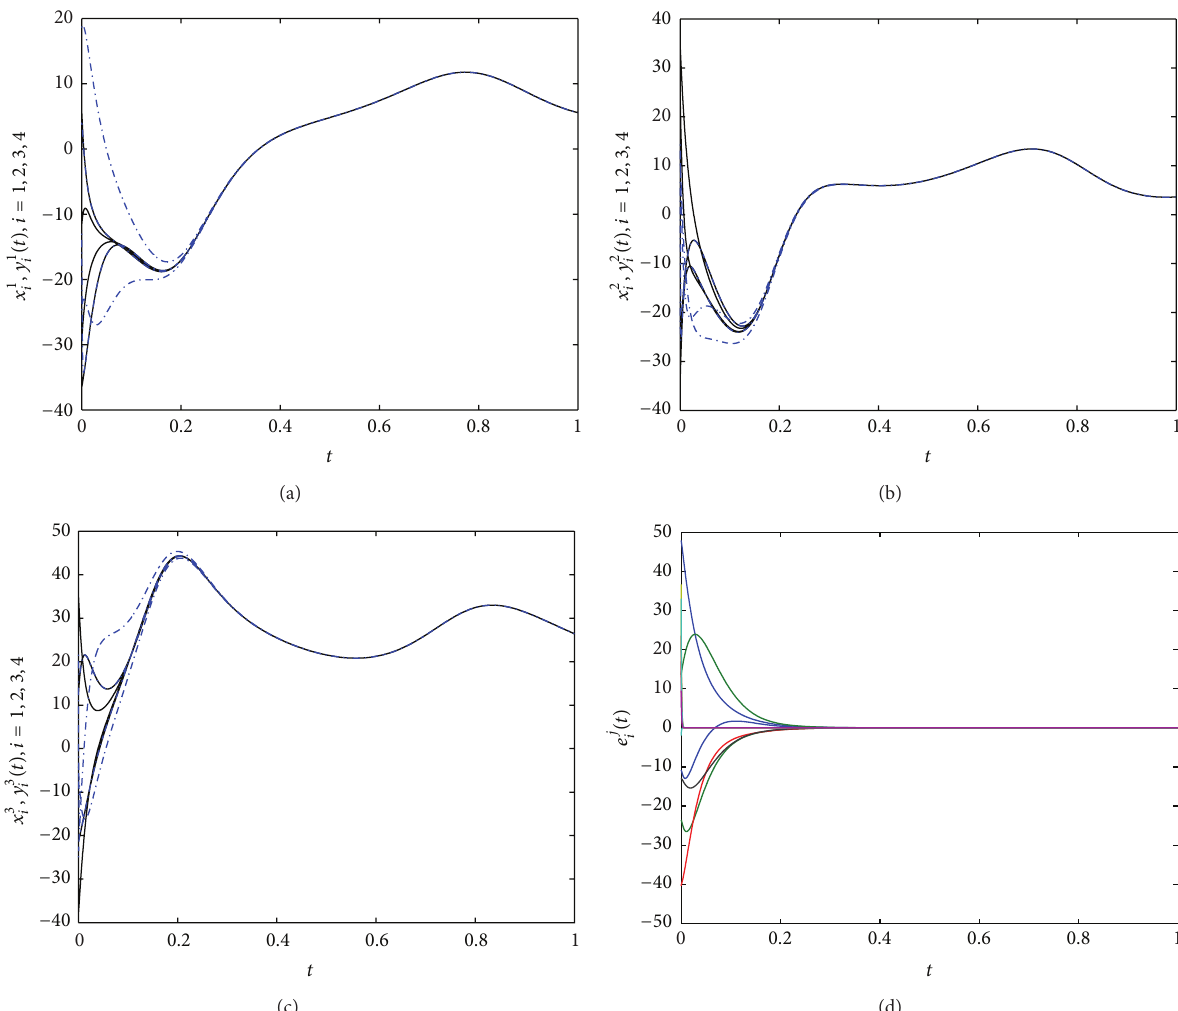
Figure 2: Time evolution between node 𝑥 𝑘 𝑖 and node 𝑦 𝑘 𝑖 , 𝑖 = 1,2, 3, 4 , 𝑘 = 1, 2, 3 , and error evolution between drive and response networks under pinning